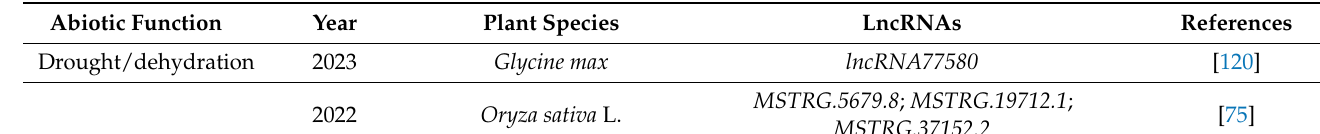
Table 2. Representative lncRNAs found to be involved in plants responding to abiotic